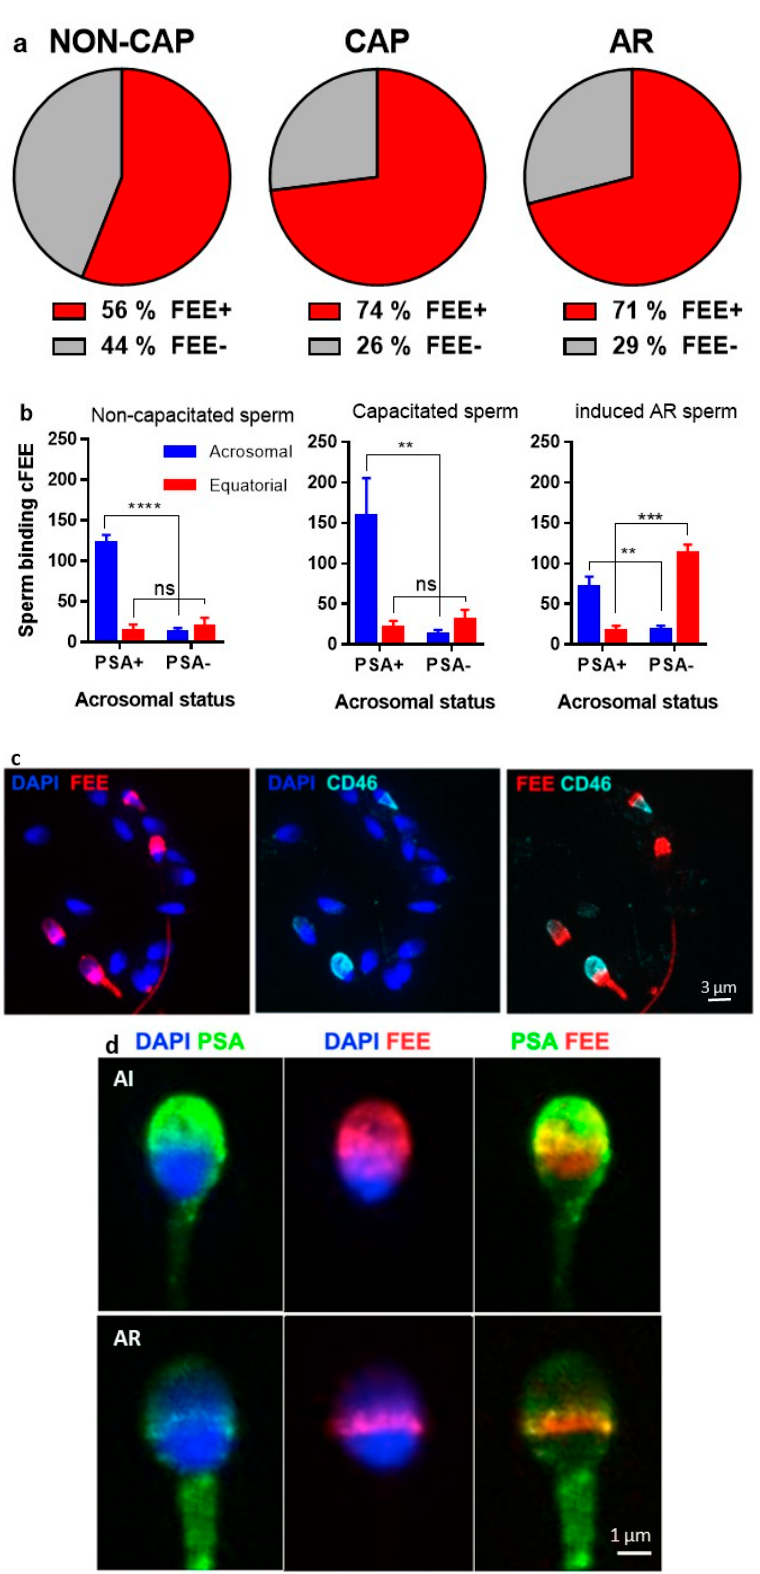
Figure 1. cFEE binding to sperm. cFEE binding pattern on human sperm depends on acrosome status. ( a ) Percentage of human sperm binding cFEE in fresh semen sample (NON ‐ CAP), after capacitation (CAP) and after acrosome ‐ reaction (AR). Dunn’s multiple comparisons after ANOVA test showed no significant differences between the groups. ( b ) Localization of cFEE binding to human sperm in NON ‐ CAP, CAP, and induced AR conditions. cFEE binding localization is shown as sperm number (mean ± s.e.m) for NON ‐ CAP sperm ( left ), CAP sperm ( middle ), and induced AR ( right ). A two ‐ way ANOVA and Sidak’s multiple comparisons test showed a significant difference in cFEE acrosomal localization between the positive and the negative PSA groups independently of sperm status (NON ‐ CAP, **** p < 0.0001; CAP, ** p = 0.005, iAR, ** p = 0.009 and *** p = 0.0002) and in cFEE equatorial localization only in the iAR group, in which the percentage of acrosome ‐ reacted sperm is important ( p = 0.0002). These data were obtained from three independent experiments where we counted over 300 sperm in each of the subgroups (NON ‐ CAP, CAP, and AR) in each experiment. ( c ) FEE and CD46 immunofluorescence on capacitated human sperm. Nuclei were counterstained by DAPI. ( d ) PSA and FEE immunofluorescence on capacitated human sperm. The upper panel shows capacitated acrosome ‐ intact (AI) spermatozoon, which binds cFEE on the acrosome. The bot ‐ tom panel shows capacitated acrosome ‐ reacted (AR) spermatozoon, which binds FEE on the equa ‐ torial region. Nuclei were counterstained by DAPI. NON ‐ CAP: non ‐ capacitated, CAP: capacitated, AI: acrosome ‐ intact, AR: acrosome ‐ reacted. 2.2. cFEE Potentiates Sperm Movement without Toxic Impact 2.2.1. cFEE Increases Sperm Movement Parameters (Table 1) Since cFEE improves the fusion index in human gametes, we investigated whether the peptide modifies sperm functions including sperm movement parameters. Results for scramble and cFEE treated sperm using CASA analysis are shown in Table 1 ( n = 38 sperm). Several parameters including average path velocity (VAP), curvilinear velocity (VCL), and straight path velocity (VSL) were significantly increased in the cFEE group when compared to the scramble group (control). BCF, STR, and LIN remained unchanged. The proportion of hyperactivated spermatozoa was significantly increased by 29% in the cFEE compared to the scramble group (13.6% versus 10.5%, p = 0.002) according to the criteria of Mortimer and Swan [15].